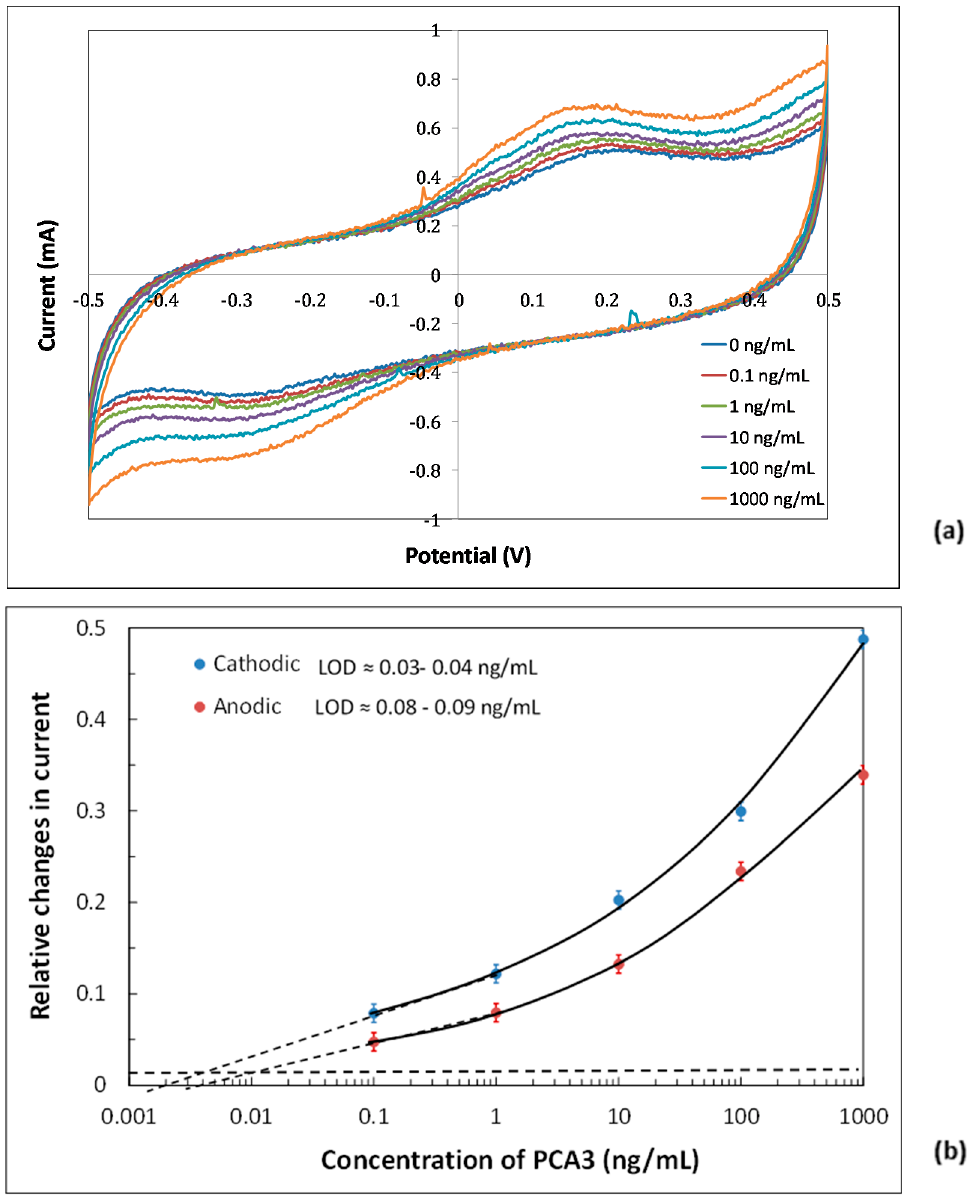
Figure 3. ( a ) A typical set of cyclic voltammograms (CV) for different concentrations of PCA3; ( b ) Concentration dependence of relative changes of cathodic and anodic currents and evaluation of LOD.